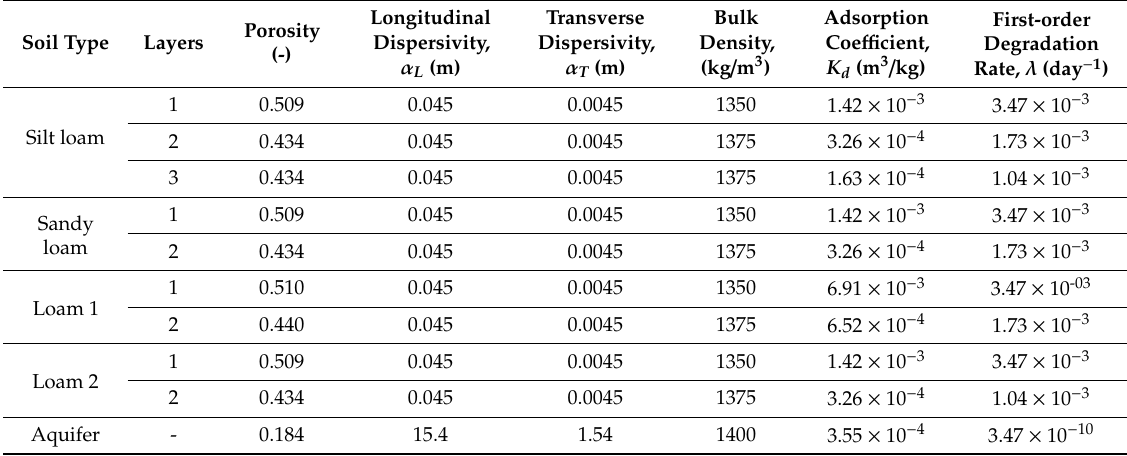
Table 4. Solute transport parameters specific to soil and solute